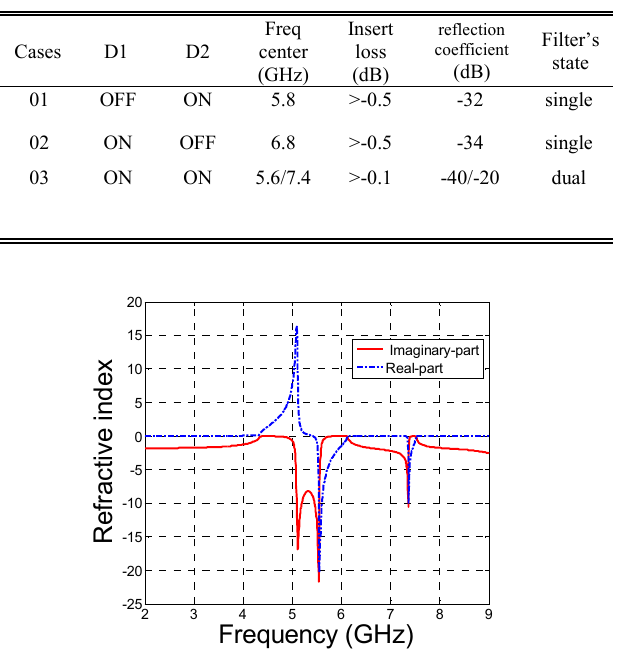
TABLE III. Details of the parameters of the filter cases depending on the PIN diodes states.